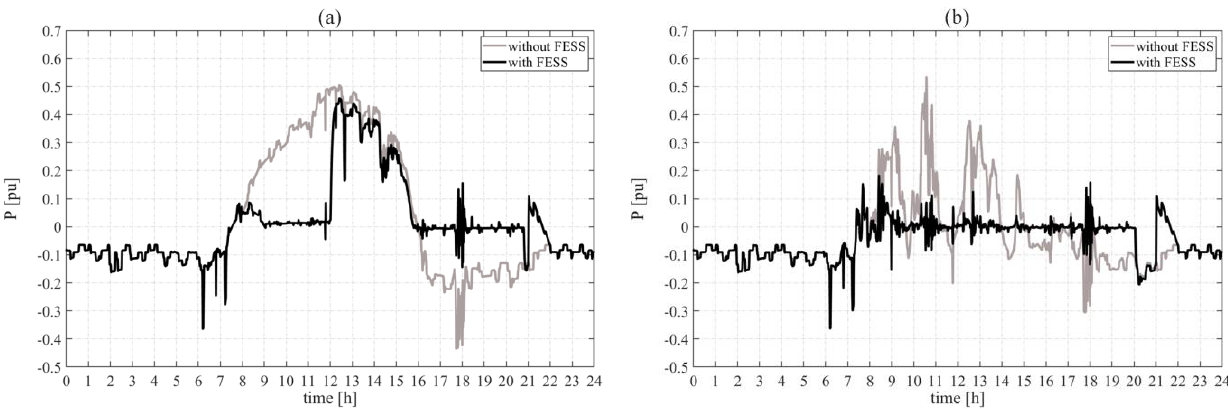
Appl. Sci. 2021 , 11 , x FOR PEER REVIEW Figure 14. Overall power exchanged with the main grid with and without FESS @720 V: cases C1 ( a ) and C2 ( b ). Figure 14. Overall power exchanged with the main grid with and without FESS @720 V: cases C1 ( a ) and C2 ( b ). Figure 14. Overall power exchanged with the main grid with and without FESS @720 V: cases C1 ( a ) and C2 ( b ).